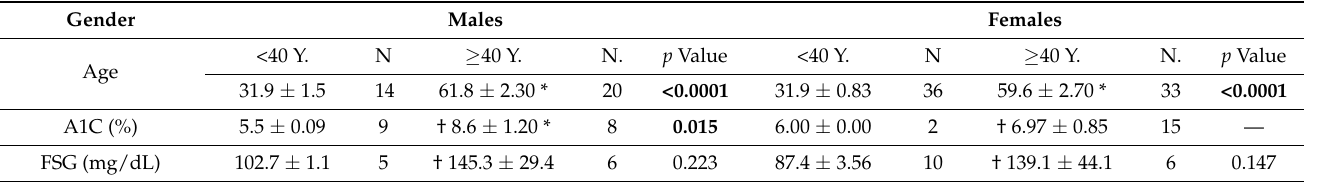
Table 2. Prevalence of the metabolic syndrome profiles in males and females of the general population with respect to age: below 40 years old (>40 Y.) or equal/after that age ( ≥ 40 Y.). † denotes risky levels. All data were presented as mean ± SEM. Mean differences of each parameter between both ages were analyzed by Students’ t -test and considered significant at * p < 0.05–NS, denoting a non-significant difference. Elders ( ≥ 40 Y.) were susceptible to diabetes in both men and women. Ages <40 Y. were susceptible to hypothyroidism in males, but susceptible to hypovitaminosis-D, hypothyroidism, and anemia in young